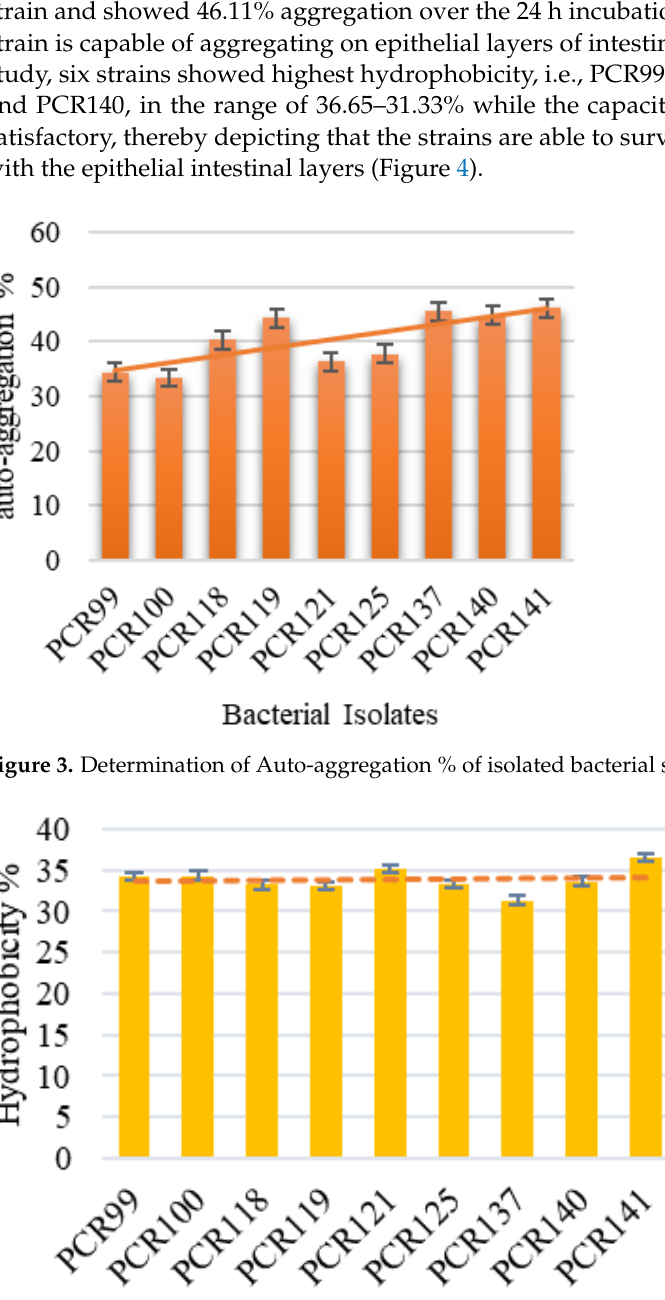
Figure 2. Detection of Bile Salt tolerance in bacterial strains. Values are means of replicate experi- ments; ±indicates standard deviation from the mean. Values differs significantly ( p < 0.05).